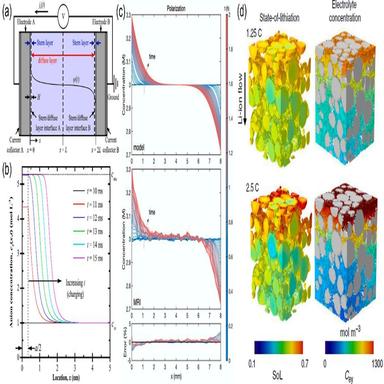
(a-b) Modelling of the electric double layer with PNP. Reproduced with permission from Elsevier. (c) Modelling of dynamic electrolyte concentration gradients with Onsager-Stefan-Maxwell theory in validation with potentiometric NMR. Reproduced with permissions from ACS publications. (d) Modelling of the state-of-lithiation and electrolyte concentration in porous NMC electrode with DFN. Reproduced with permissions from Springer Nature.